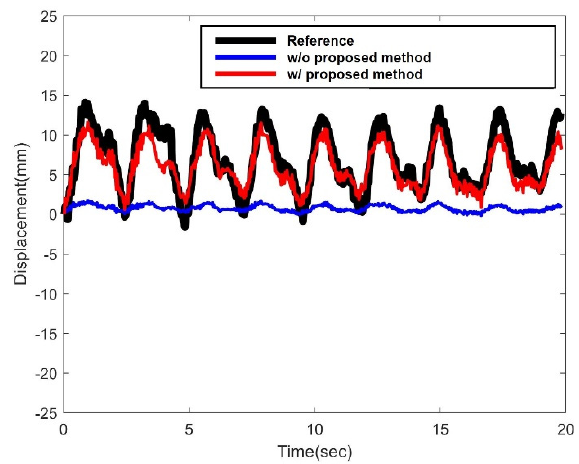
Figure 16. Estimated displacement for the on-site validation test.